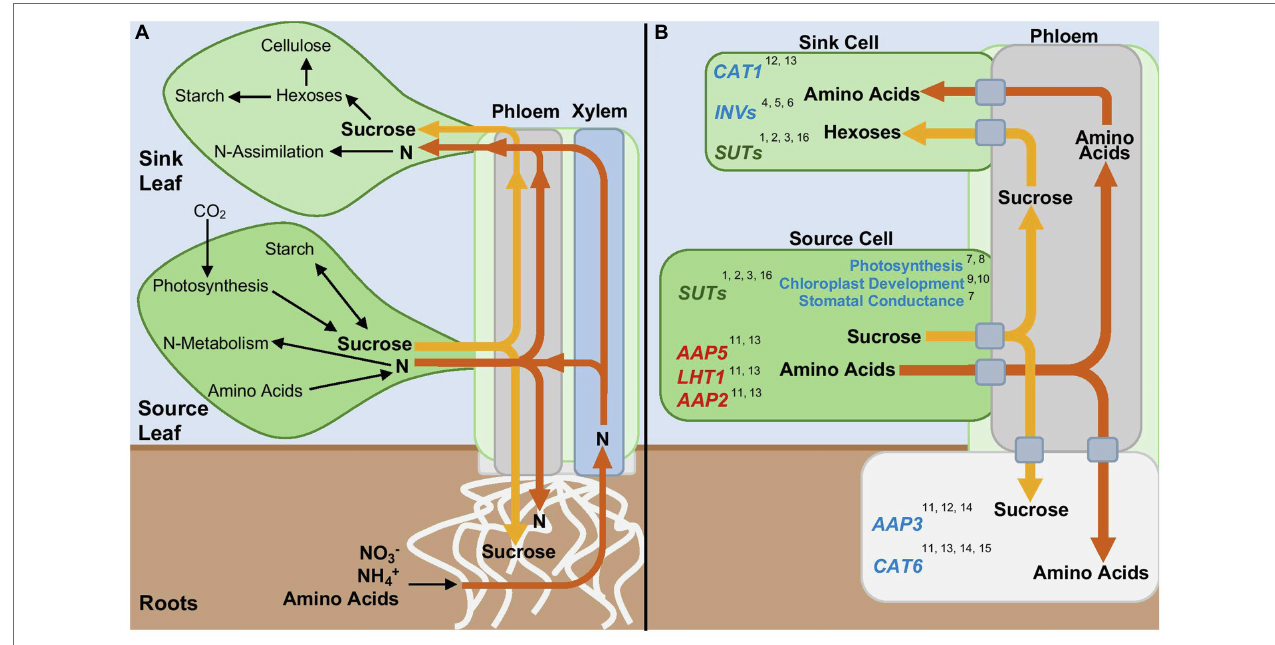
FIGURE 1 | Source-Sink Relationships in Plants. (A) Whole plant movement of nitrogen containing compounds (N, orange arrows) and sugars (yellow arrows) between source and sink tissues. (B) Regulation by cytokinin of specific enzymes, transporters, and processes involved in source-sink relationships. Blue and red symbolize positive or negative regulation by cytokinin, respectively. Green symbolizes both a positive and negative regulation by cytokinin. Numbers correspond to references. References: 1. Harms et al., 1994; 2. Ninan et al., 2019; 3. Song et al., 2015; 4. Ehness and Roitsch, 1997; 5. Godt and Roitsch, 1997; 6. Yang et al., 2014; 7. Chernyad’ev, 2000; 8. Ahanger et al., 2018; 9. Boasson and Laetsch, 1969; 10. Okazaki et al., 2009; 11. Brenner et al., 2005; 12. Lee et al., 2007; 13. Kiba et al., 2011; 14. Kiba et al., 2005; 15. Yokoyama et al., 2007; and 16. Jian et al.,